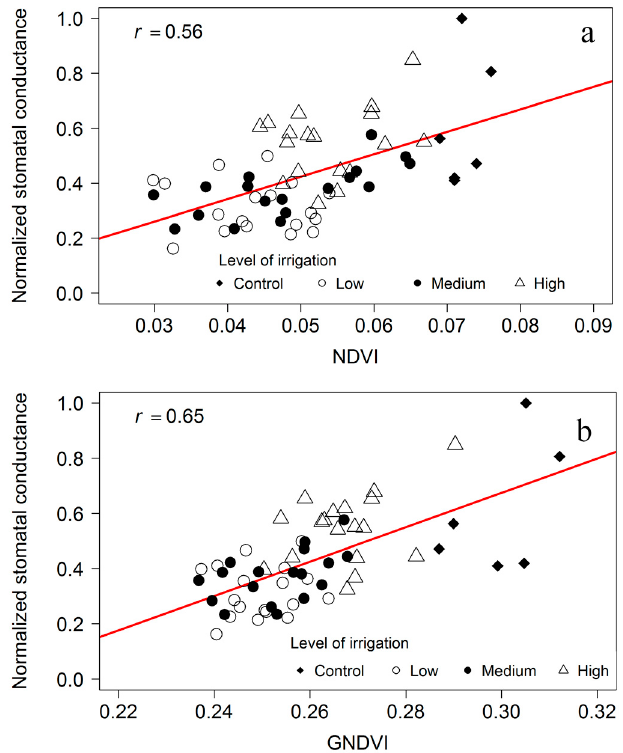
Figure 9. Correlations between ( a ) NDVI and ( b ) GNDVI data with stomatal conductance at 44 DBH.